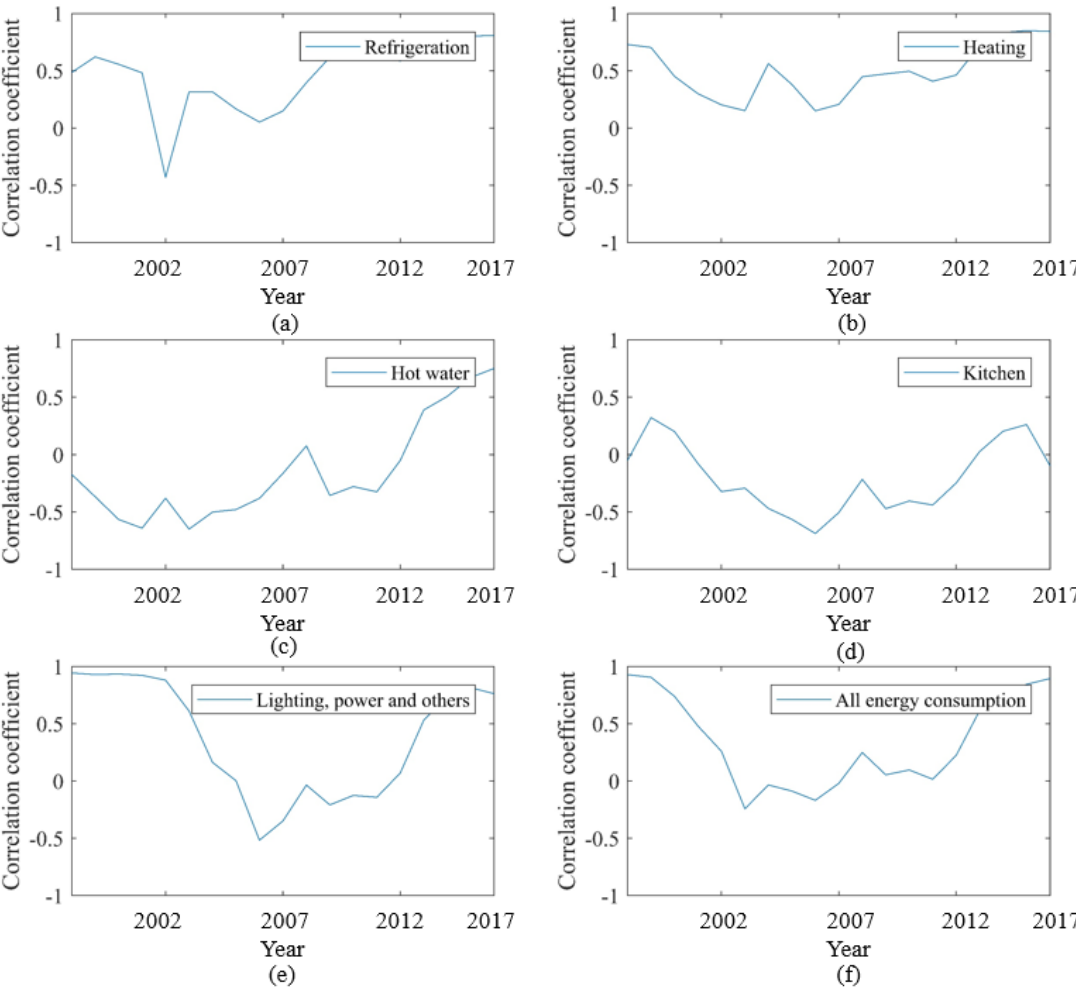
Figure A2. The policy identification results of residential (refrigeration, heating, hot water, kitchen, lighting, power and others) (( a ) Refrigeration; ( b ) Heating; ( c ) Hot water; ( d ) Kitchen; ( e ) Lighting, power and others; ( f ) All energy consumption).